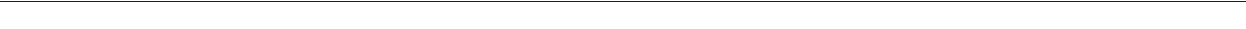
Fig. 8 S6Kinase-mediated USP11 phosphorylation regulates its interaction with eIF4B. a Toledo and SUDHL6 were treated with indicated PI3K signaling inhibitors (LY294002: PI3K inhibitor (1 µ M), AZD5363: Akt inhibitor (500 nM), Rapamycin: mTOR inhibitor (50 nM), Torin 1: mTOR inhibitor (250 nM), PF-4708671: S6Kinase inhibitor (1 µ M)) in presence or absence of C75. Post treatment, cell lysates were probed for eIF4B. GAPDH was used as